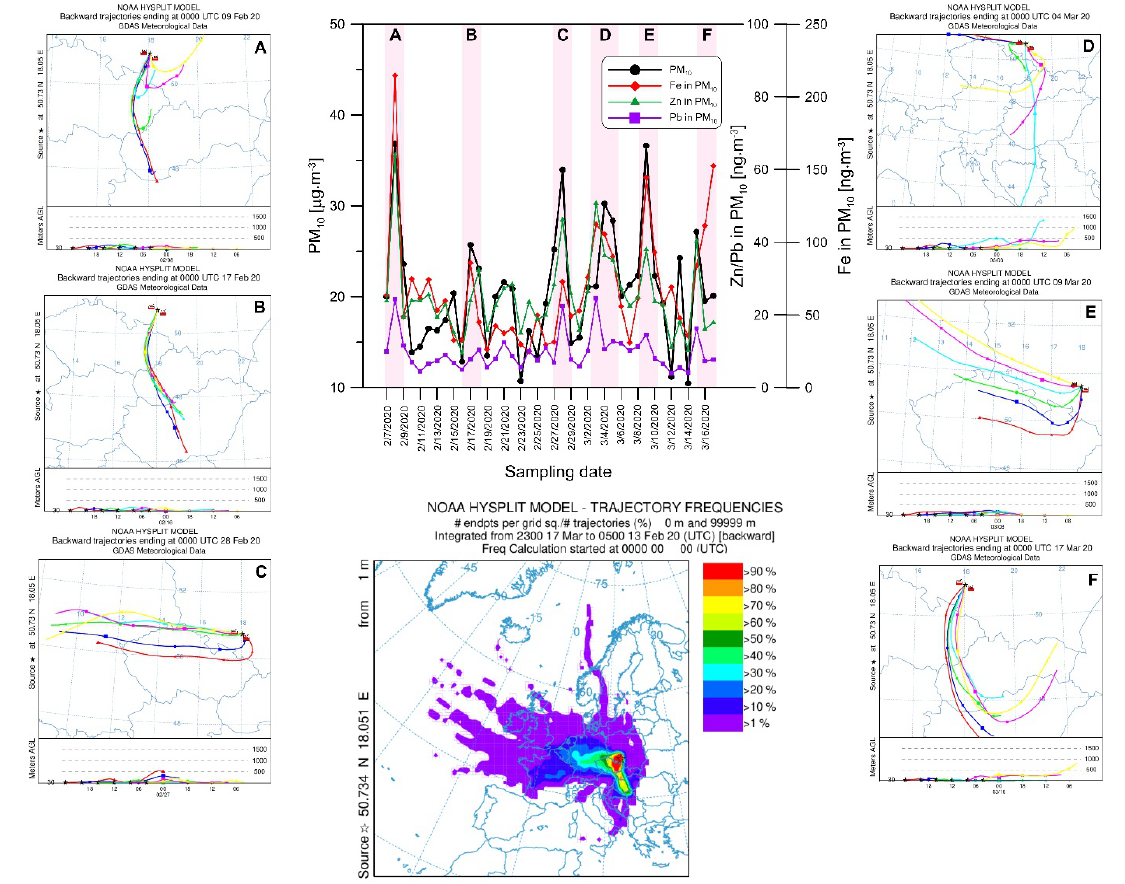
Figure 2. HYSPLIT trajectory frequencies and 2 4 h air backward trajectories in Kotórz calculated for given episodes ( A, B, C, D, E, F ).